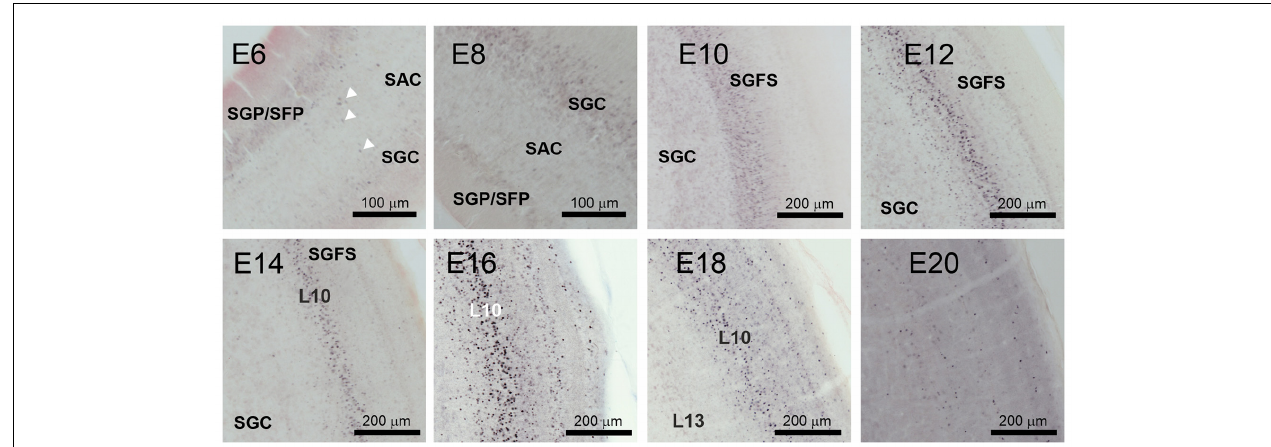
FIGURE 5 | AP-2 δ expression during optic tectum layer formation. DAB labeling of AP-2 δ immunopositive cells from E6 to E20 in the developing optic tectum. Panels (E6–E8) show periventricular layers (SGP/SFP), marginal fiber layer ( SAC, stratum album centrale ), and granular layer ( SGC, startum griseum centrale ). White